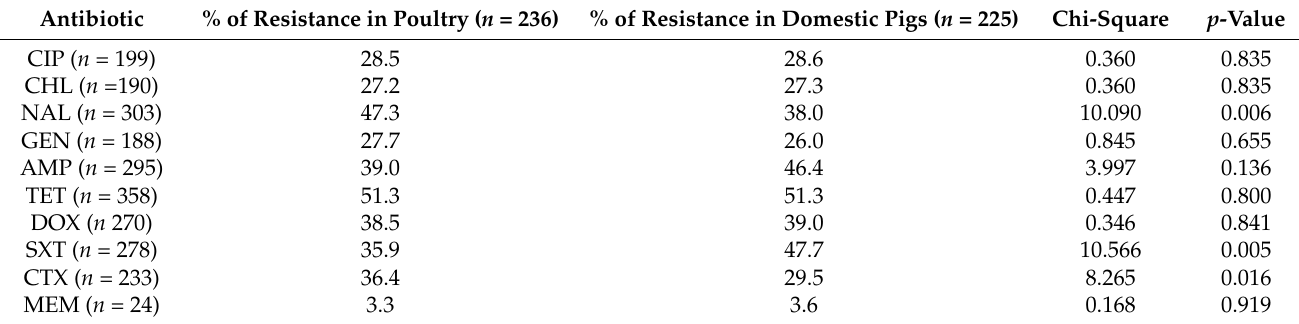
Table 2. Comparative analysis of antibiotic resistance of isolates from poultry versus domestic pigs.